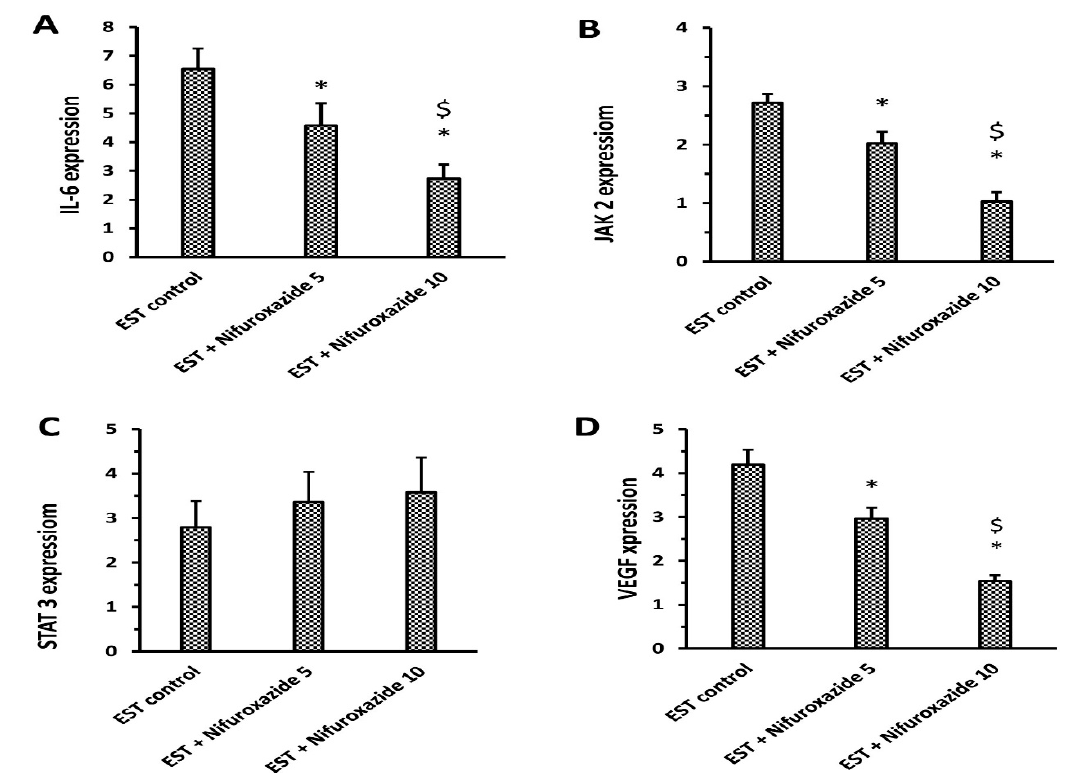
Figure 4. RT-PCR assays for IL-6, JAK2, STAT3, and VEGF in the solid tumors. ( A ) IL-6, ( B ) JAK2, ( C ) STAT3 and ( D ) VEGF expression; Column charts demonstrate data as mean ± S.D., and comparison was achieved by applying one-way ANOVA and Bonferroni’s test at P less than 0.05. * Versus the EST control, $ Versus the EST + Nifuroxazide (5 mg/kg) group.